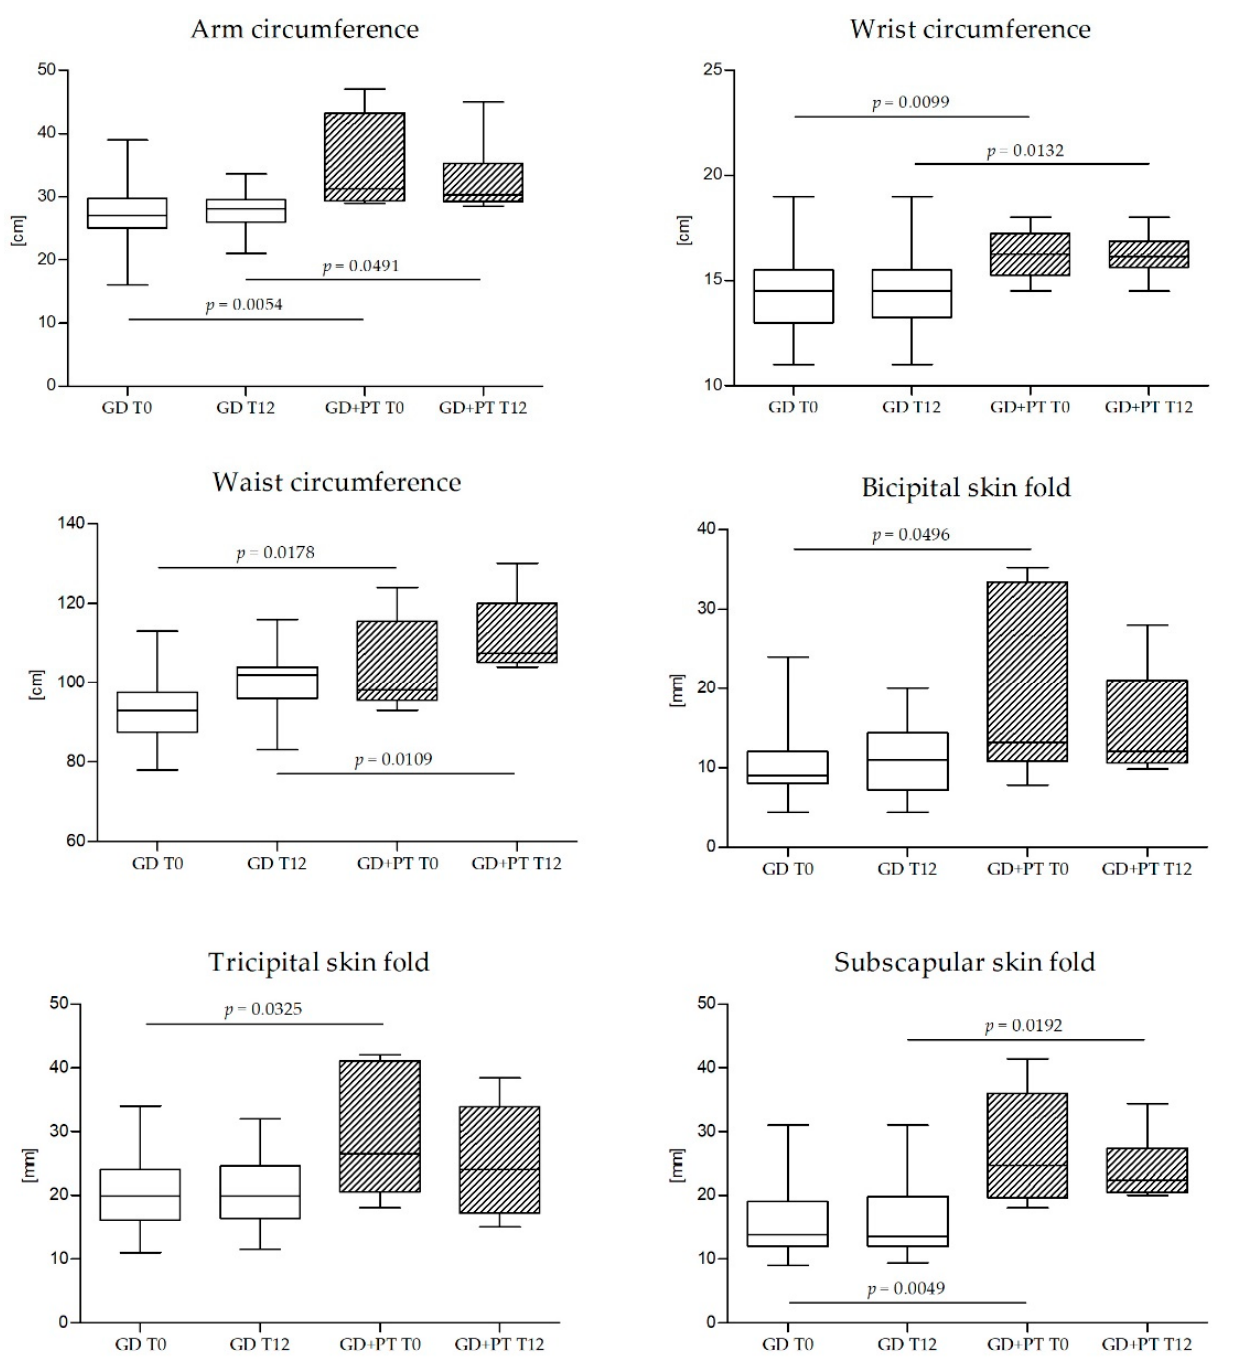
Figure 2. Longitudinal trend of anthropometric parameters of subjects with GD who required therapy to normalize blood glucose levels (GD+PT) at enrollment (T0; n = 6) and at and the end of the study after 12 weeks (T12; n = 6) with subjects who did not require pharmacological intervention (GD) at T0 ( n = 45) and at T12 ( n = 34). GD—subjects with gestational diabetes mellitus who did not require pharmacological therapy. GD+PT—subjects with gestational diabetes mellitus who required pharmacological therapy. T0—at enrolment. T12—after 12 weeks.